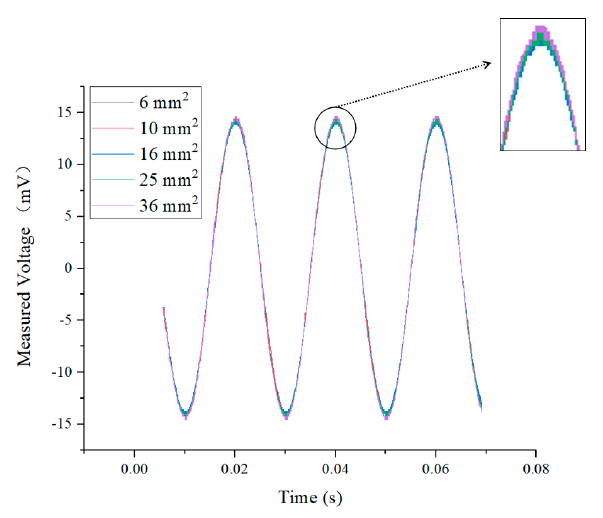
Figure 18. Multi-line warp test comparison chart.